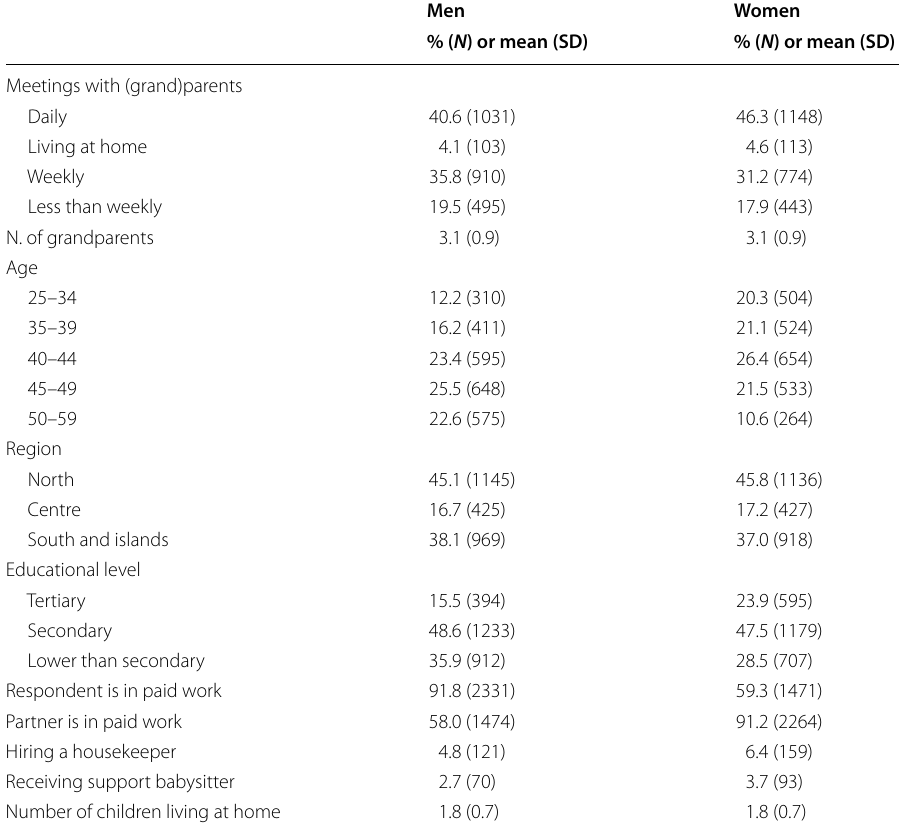
Table 1 Sample descriptive